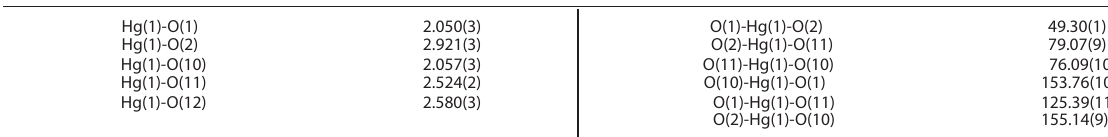
Table 4. Selected bond lengths (Å) and angles (°) for complex 2